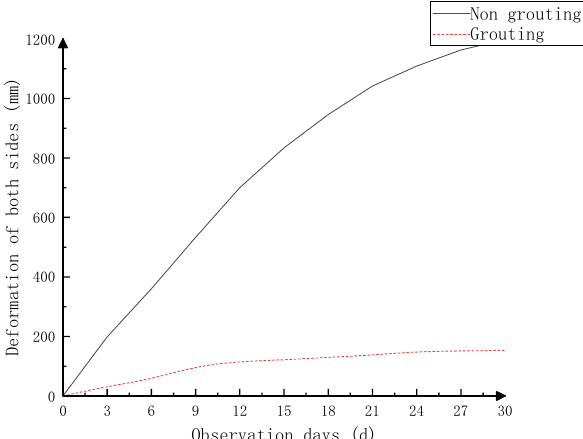
Figure 13. Comparison of deformation between the nongrouted and grouted